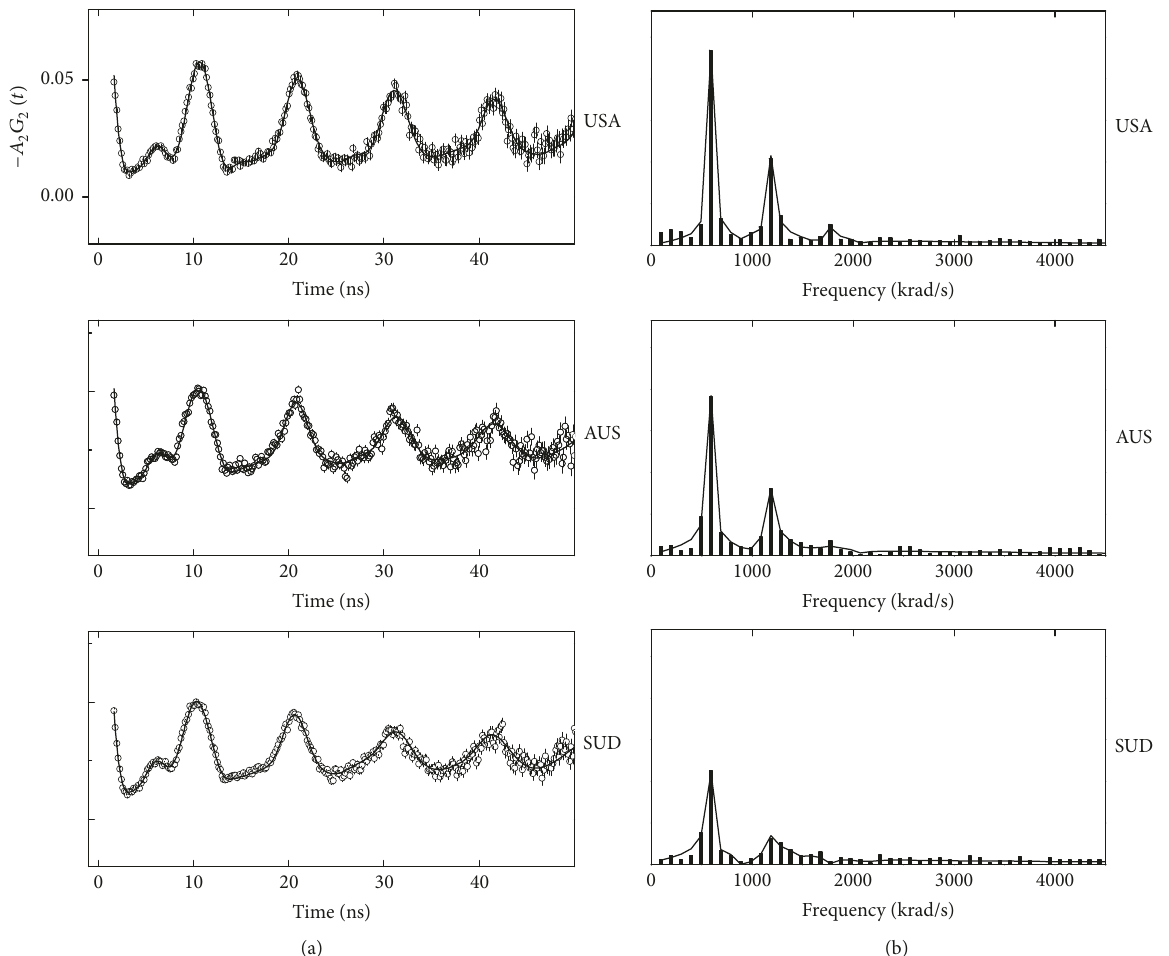
Figure 3: PAC spectra for zircon sands. The experimental spin rotation curves 𝐴 2 𝐺 2 (𝑡) are shown on (a); the Fourier transform amplitude spectra are plotted on (b). Solid lines represent the least-squares-fitted PAC spectra and their respective Fourier transforms obtained with the values given in Table 3 for the fitting